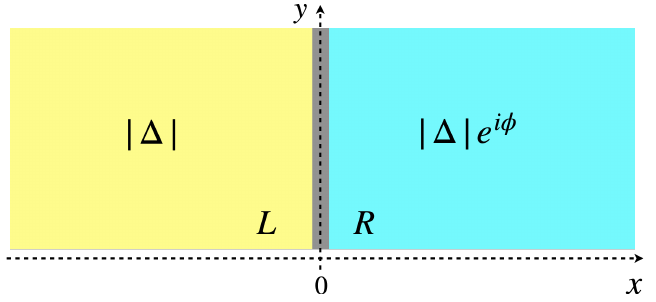
Figure 4: Schematic showing the Josephson junction between two nodal SCs. The pairing ∆ is in general complex and differs in phase between the two sides ( L and R ) of the junction as given by Eq. (7a). The two sides are separated by a δ − function barrier given in Eq.